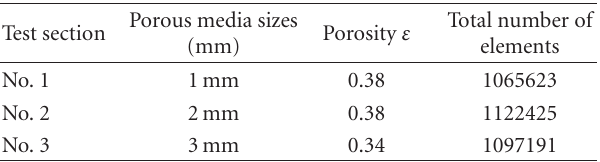
Table 1: Geometry and mesh parameters. Porous media sizes Test section